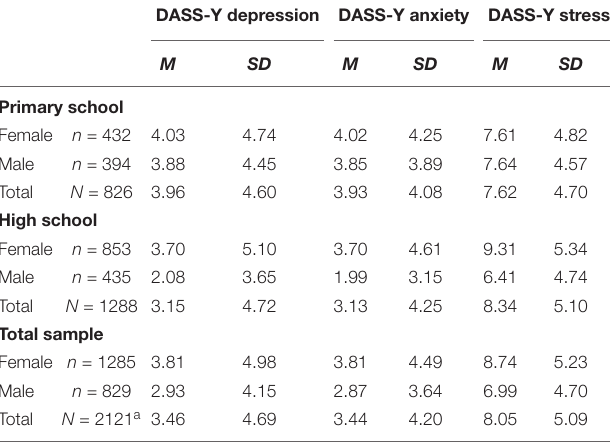
a n = 7 missing gender